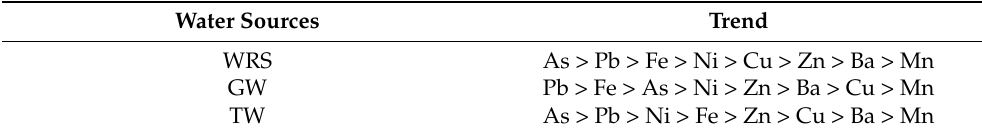
Table 7. Trends of HMM concentrations (from highest to lowest) in the DW of Marinduque Province,